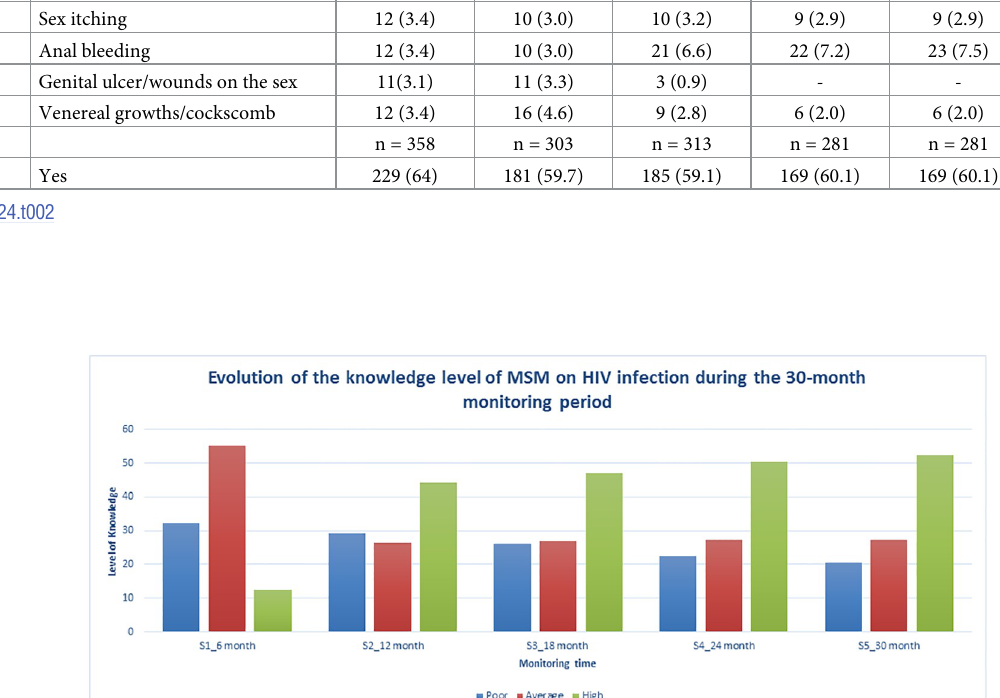
PLOS ONE | https://doi.org/10.1371/journal.pone.0233624 June 9,